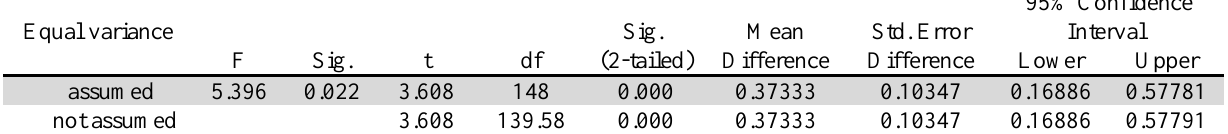
t-test in order to compare the means Equal variance F Sig. assumed not